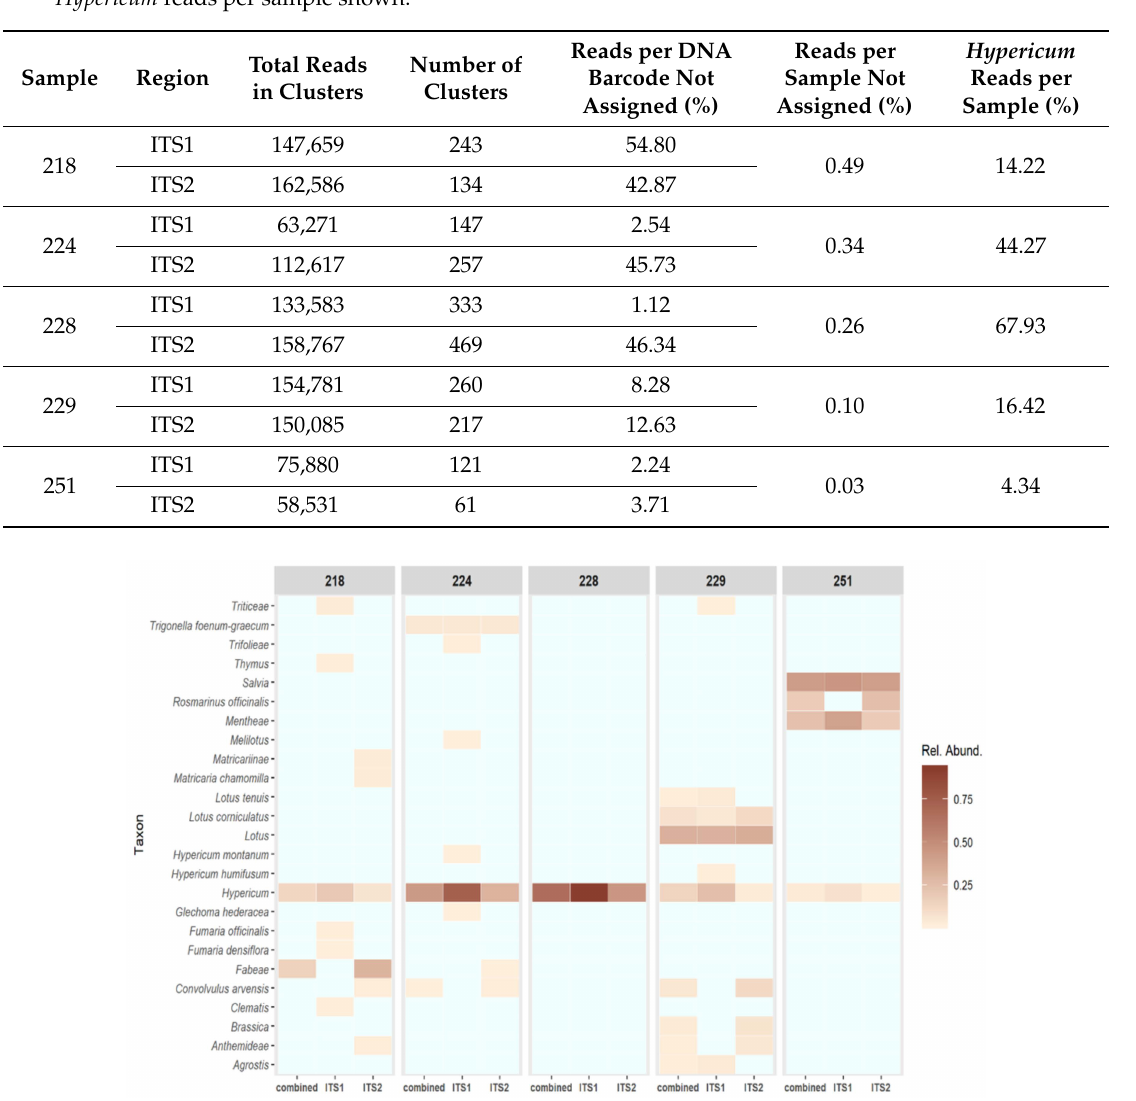
Figure 4. The heatmap displays the relative abundance of reads matching a given taxon after running BLAST against the NCBI